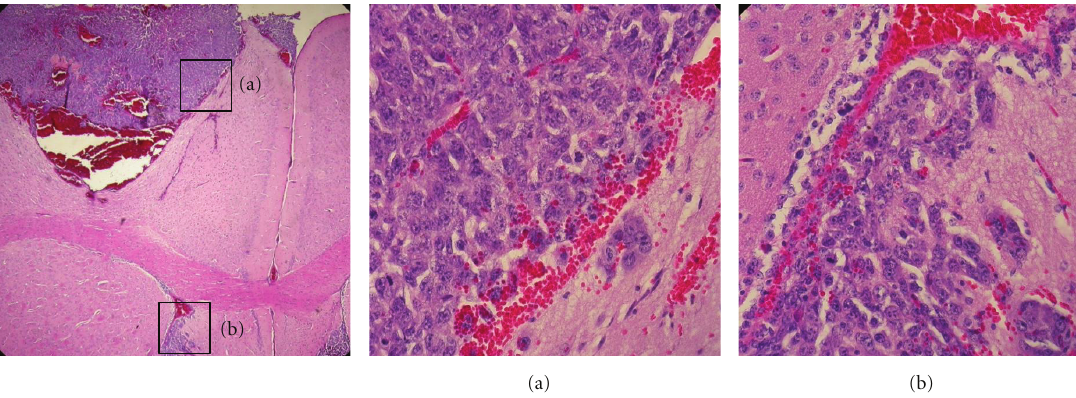
Figure 5: Development of an immunocompetent intracranial model of breast cancer brain metastases. Female A/J mice in two cohorts ( n = 4, each) were given intracranial injections of 1 × 10 4 or 5 × 10 4 cells/5 μ L. By days six (5 × 10 4 cohort) and nine (1 × 10 4 ) post- injection, all mice in each cohort had been euthanized due to the onset of neurological symptoms. Brains were harvested for histological examination. Shown are hematoxylin and eosin-stained sections from a representative specimen. Note the massive tumor at the injection site in the first panel (40x magnification) with associated hemorrhaging. Insets (400x) show the relatively well circumscribed border of the main tumor (a) and the more invasive character of a distant tumor nest (b).